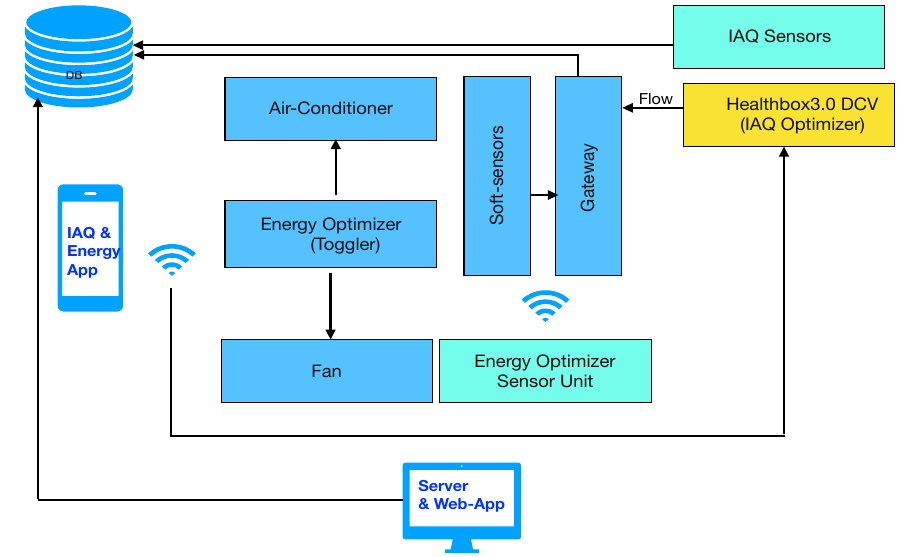
Figure 4. Schematic of the novel hybrid ventilation system.